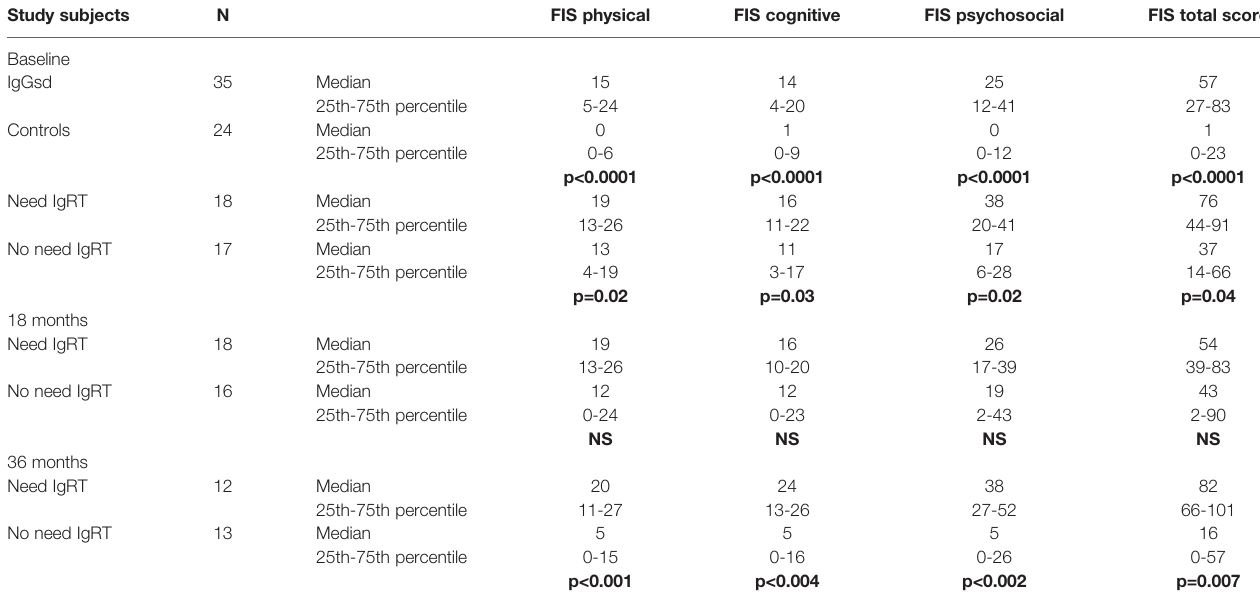
TABLE 2B | FIS-score in IgGsd and controls at different time